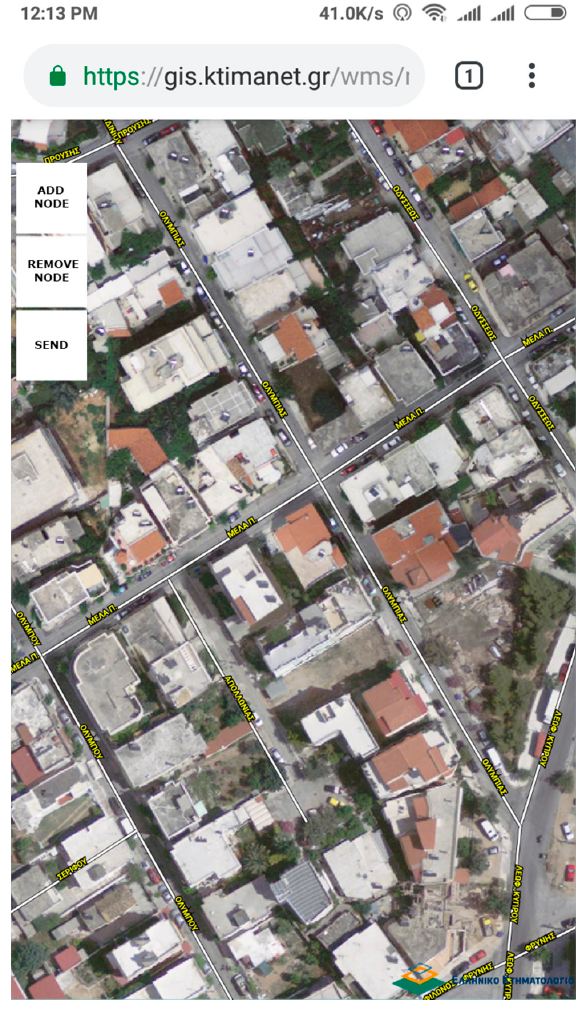
Figure 9. The web application tracks user position and gradually creates the parcel’s boundary.